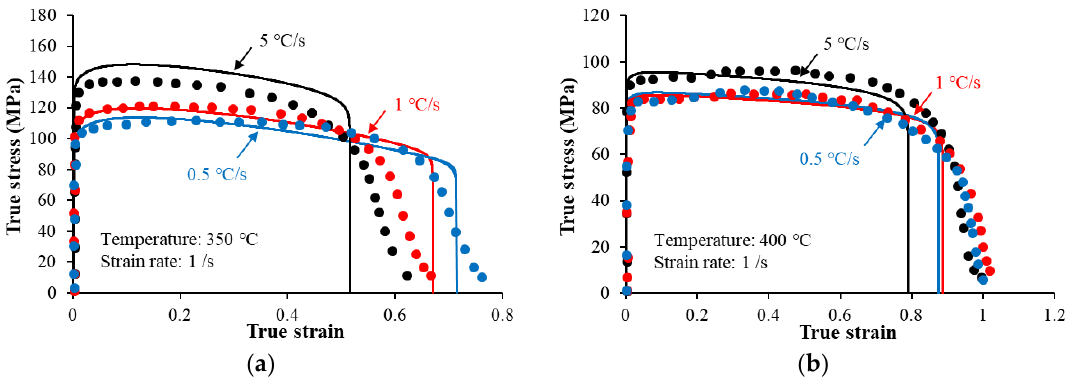
Figure 7. True stress and strain curves of AA7075-T6 heated to ( a ) 350 °C and ( b ) 400 °C with different heating rates under strain rate of 1/s (experimental results: symbols; modeling results: lines).